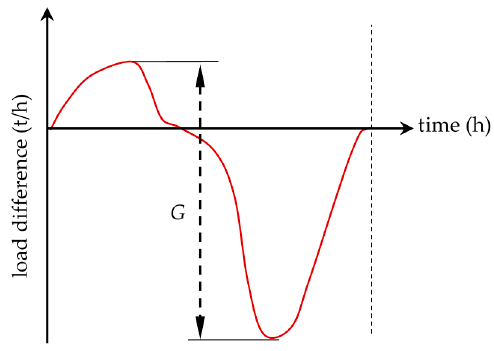
Figure 4. Integral curve of load difference. It is the integral of the difference between real-time load and average load. G is the difference between the maximum and minimum values on the integral curve.